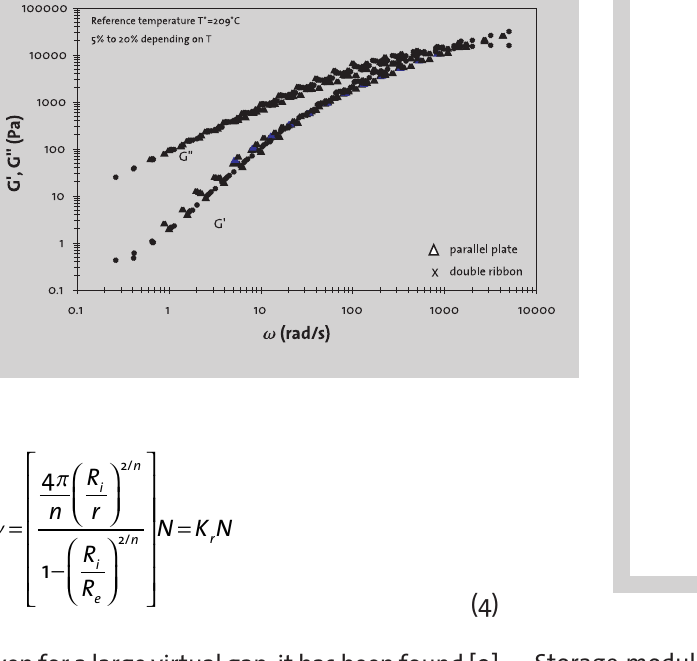
Figure 3 (left): Comparison of mechanical spectra of EVA 40-55 at a reference temperature of 209°C obtained with a parallel-plate geometry (triangle) and with the rheo-reactor Figure 4 : Couette analogy for internal